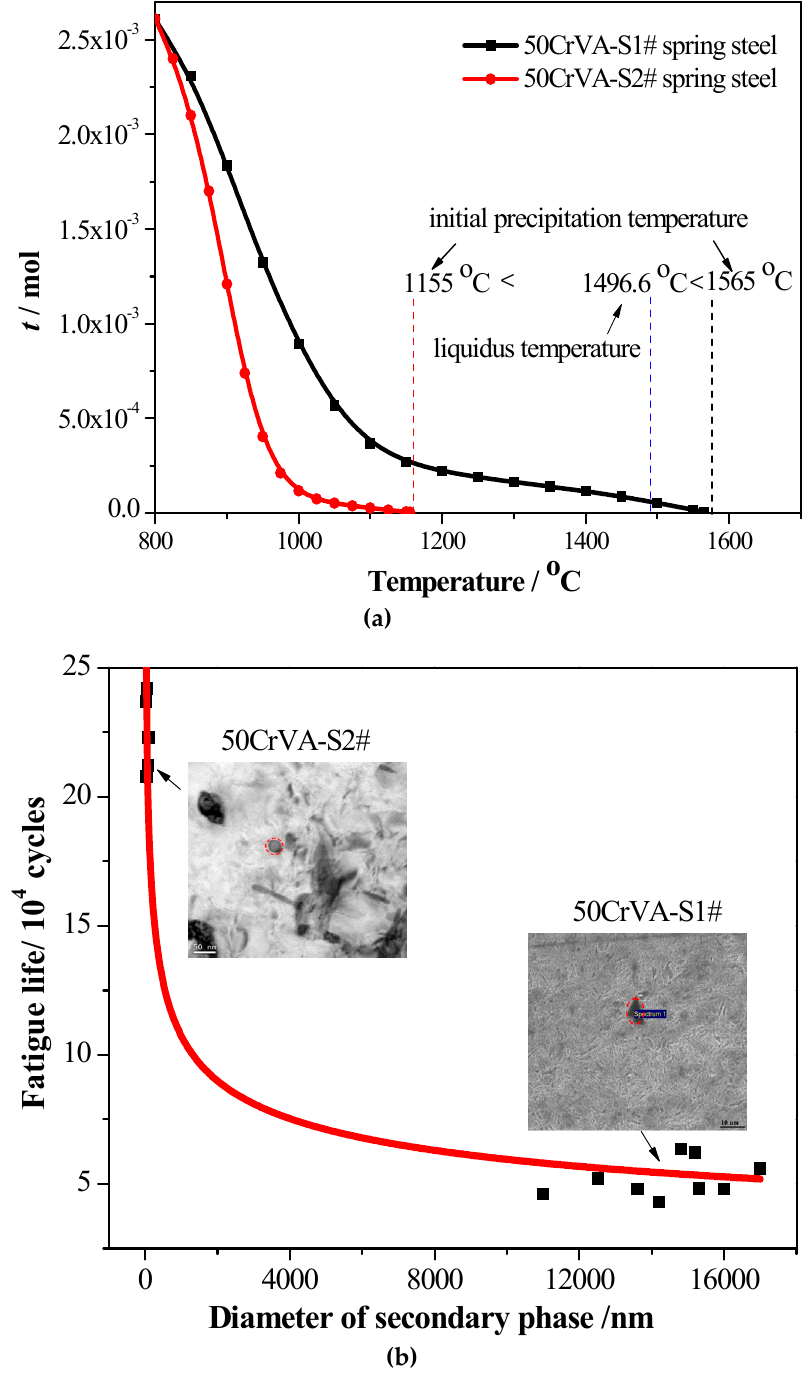
Figure 7. ( a ) The initial precipitation temperature of 50CrVA and ( b ) the relationship between secondary phase size and fatigue life in 50CrVA. Table 3. Matrix microstructure and hardness of the 50CrVA after fatigue testing.